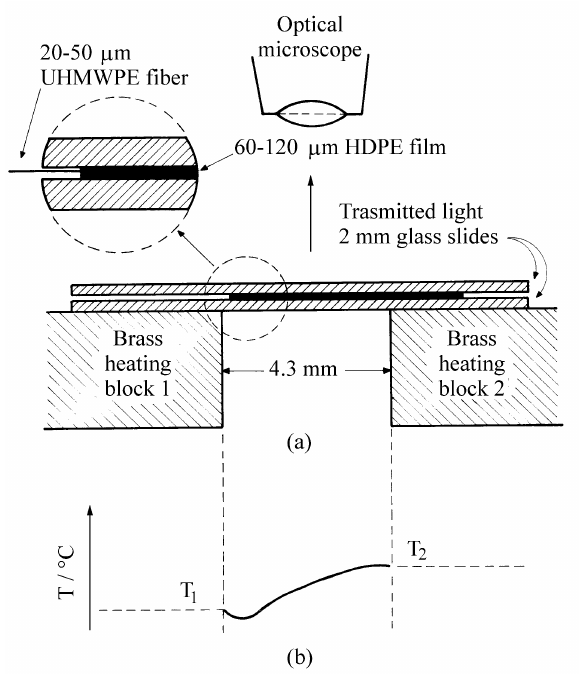
Figure 1. Schematic view of temperature gradient hot stage in (a), typical temperature gradient for T 1 = 132 °C e T 2 = 135 °C em (b).